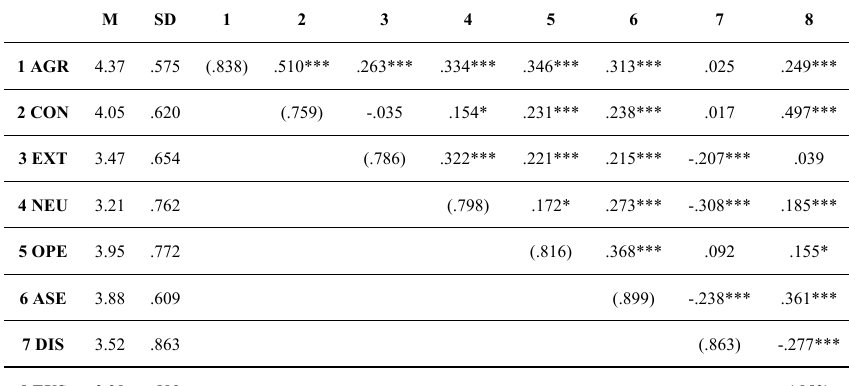
Statistic descriptives, correlations and Cronbach’s alpha